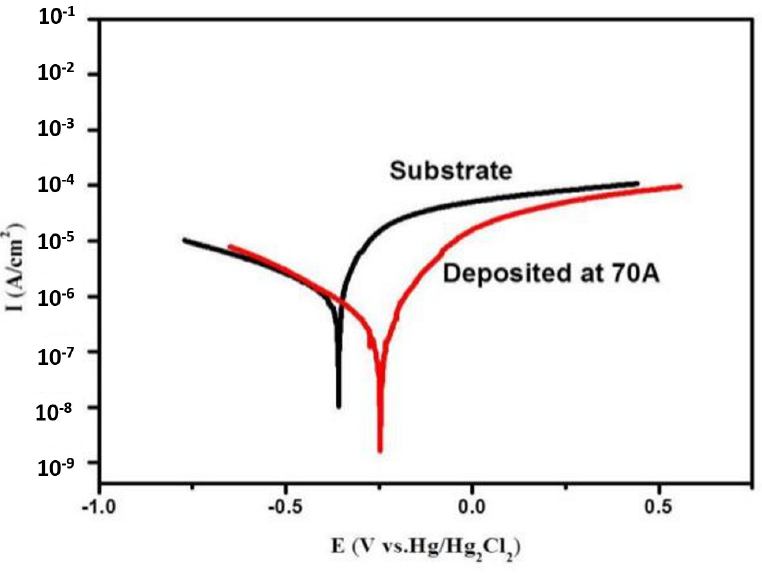
Figure 10. Polarization curves of cemented carbide and CrSiN coatings deposited at 70 A.